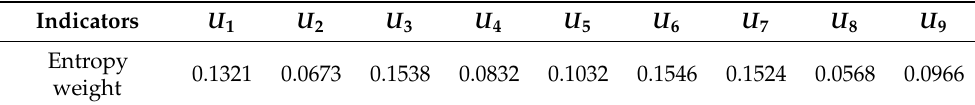
Table 4. Flood Disaster Risk Assessment Entropy weights Table.